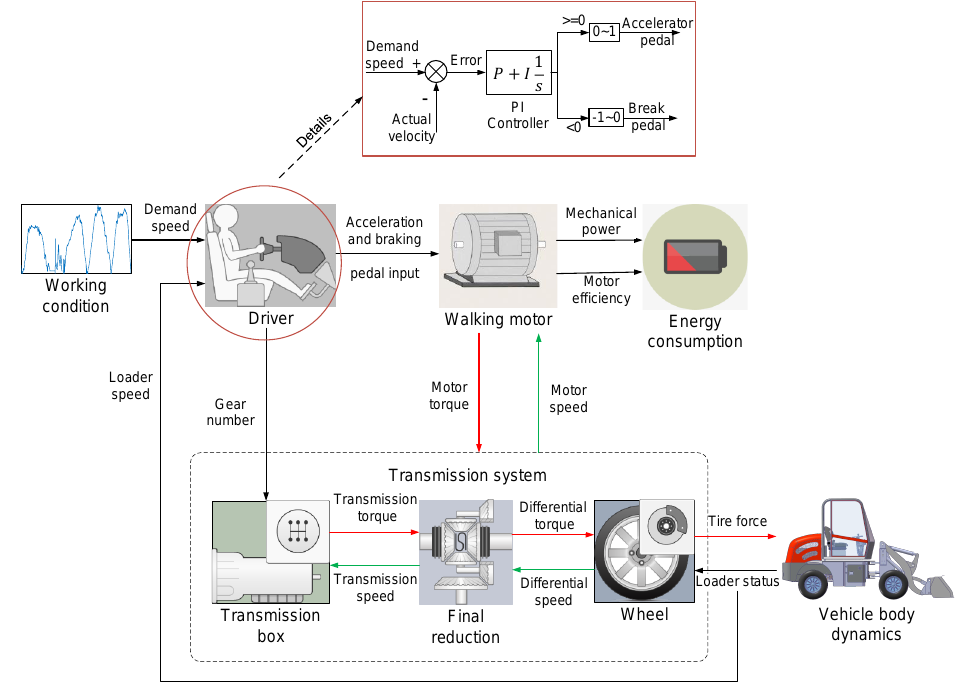
Figure 7. Schematic diagram of the walking system. Table 4. Parameters of the main components of the hydraulic